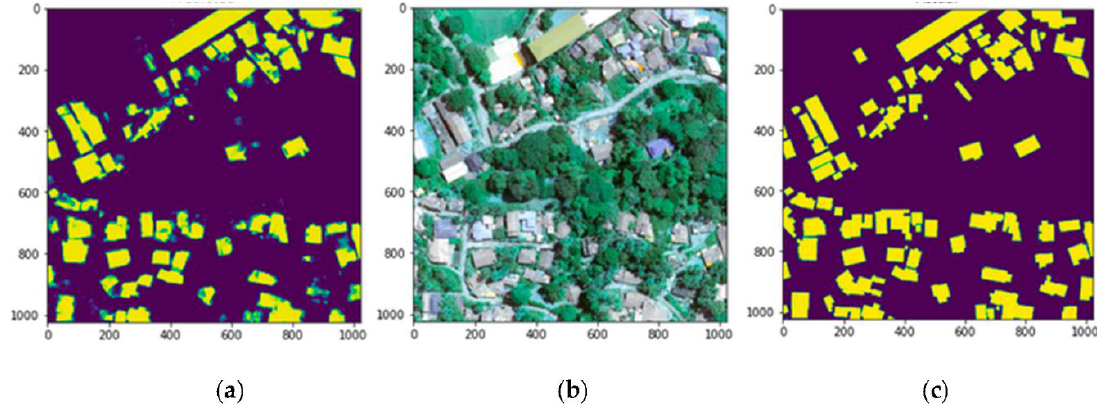
Figure 9. Building detection results for the Ratnapura UAV dataset, which is an entirely new area to the model and only used as test data (( a ): model results, ( b ): RGB images, ( c ): ground truth).